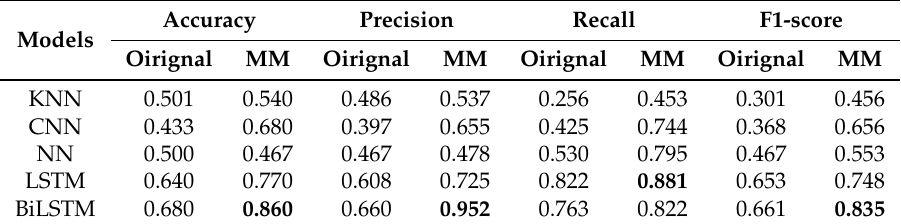
Table 1. Comparison results under the discrete wavelet transform on level